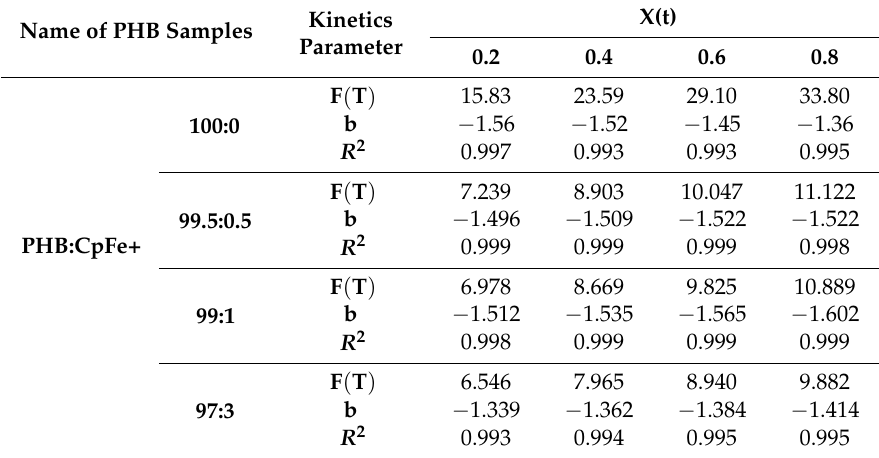
Table 4. F ( T ) and b values by MO approach for pure PHB and PHB/CpFe + nanocomposites.